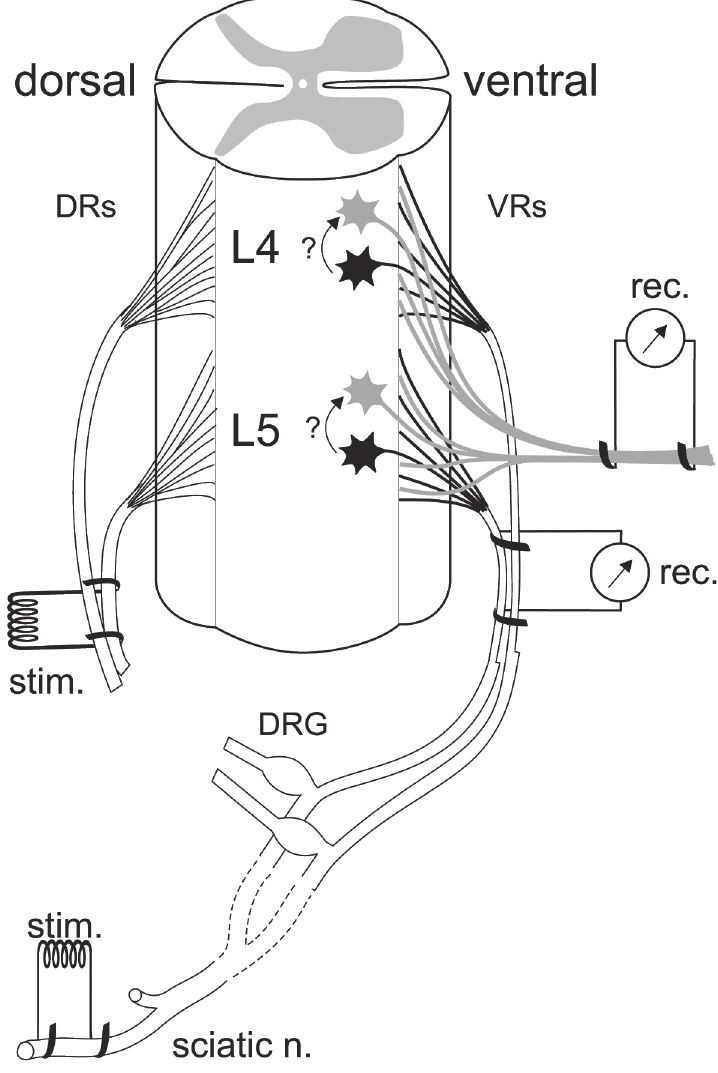
Fig 2. Schematic diagram illustrating the preparation used for the acute electrophysiological experiment. Dorsal roots (DRs), ventral roots (VRs), dorsal root ganglia (DRG) and the lumbar spinal cord are outlined. After intercollicular decerebration, the ether anesthesia is discontinued and a laminectomy exposes the lumbar cord, DRs L3 through S2 are cut, DRs L4 and L5 are mounted on stimulating electrodes, and finally VRs L4 and L5 are isolated and mounted on diphasic recording electrodes. A tiny fascicle of VR axons is initially cut and diverted on monophasic recording electrodes. After a series of antidromic (sciatic nerve) and orthodromic (DRs) stimulations are performed, while recording from VR axons both diphasically and monophasically, a further tiny bundle of axons is shifted to the monophasic recording electrodes and the stimulation series repeated. This procedure is reproduced about 10 times until most, although not all, VR axons are diverted to the monophasic recording electrodes. The cell bodies in the ventral horn and the axons of the motor neurons invaded antidromically (from spikes elicited in the sciatic nerve) are represented in black, while those possibly receiving an electrically-transmitted depolarization and their axons are represented in gray. Arrows and question marks depict the possible electrical coupling of motor